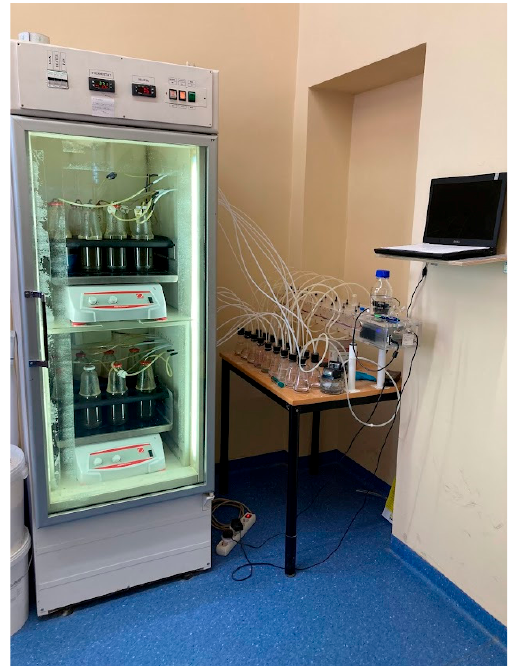
Figure 3. Batch BMP test system with an incubator capable of maintaining temperatures between 25 and 60 °C, orbital shaker (Ohaus-HEAVY DUTY ORBITAL SHAKERS) that provides a rotating orbital of 2 cm and a maximum rotation speed of 500 RPM. Table 3. AD sample loading and sample ID for all experiments performed. DWW DAF—dairy wastewater dissolved air flotation; MPWW DAF—meat processing wastewater dissolved air flotation; BHW—biomass hydrolysis waste; SAS—surface active substance. Table shows the reference BMP values for the inoculum used in each repetition.